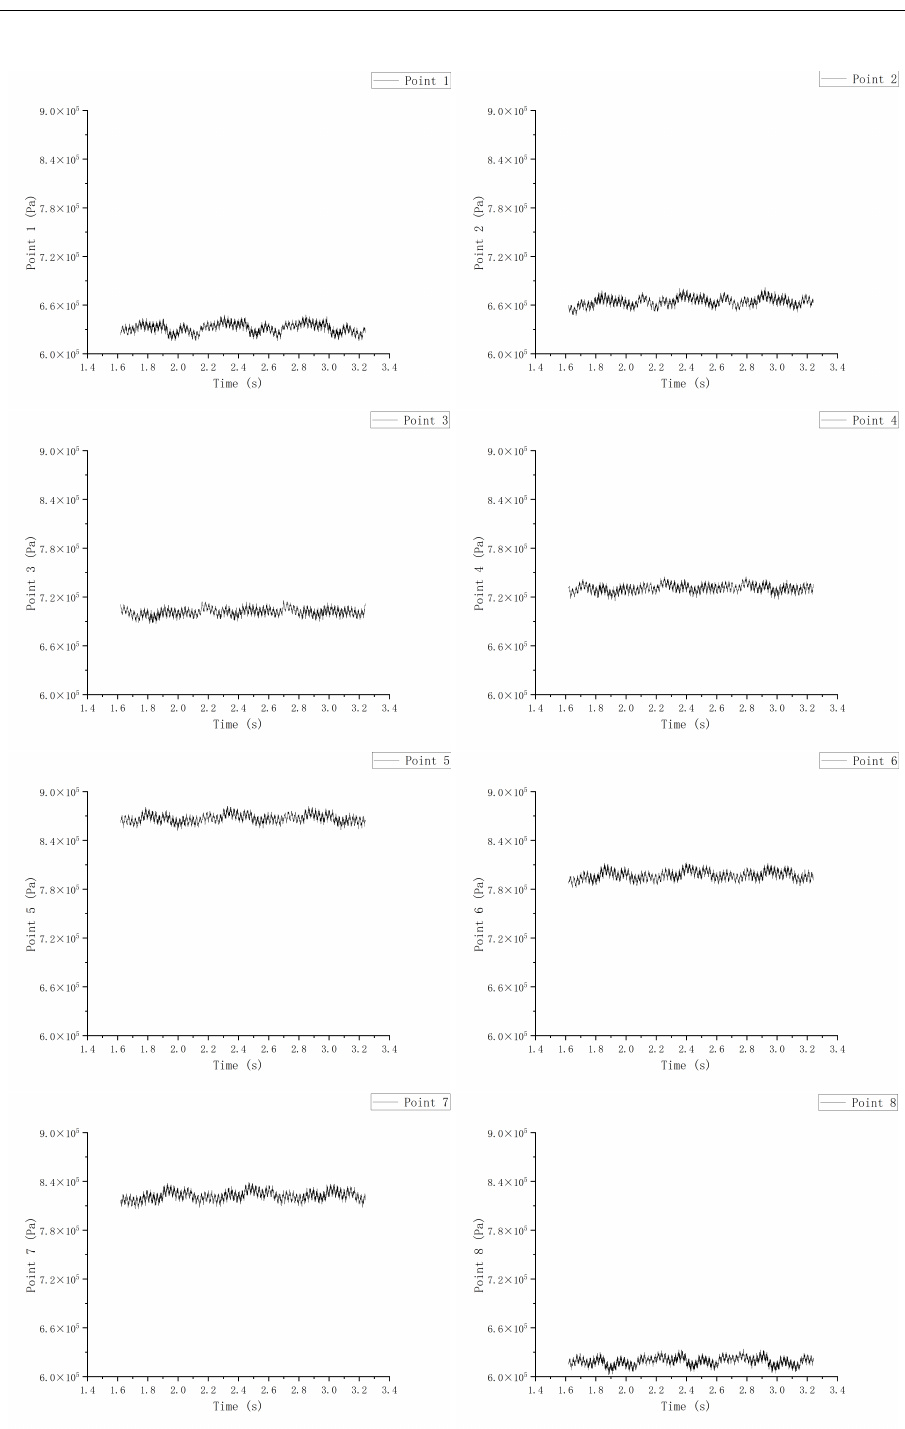
Figure 22. The pressure distributions of the middle